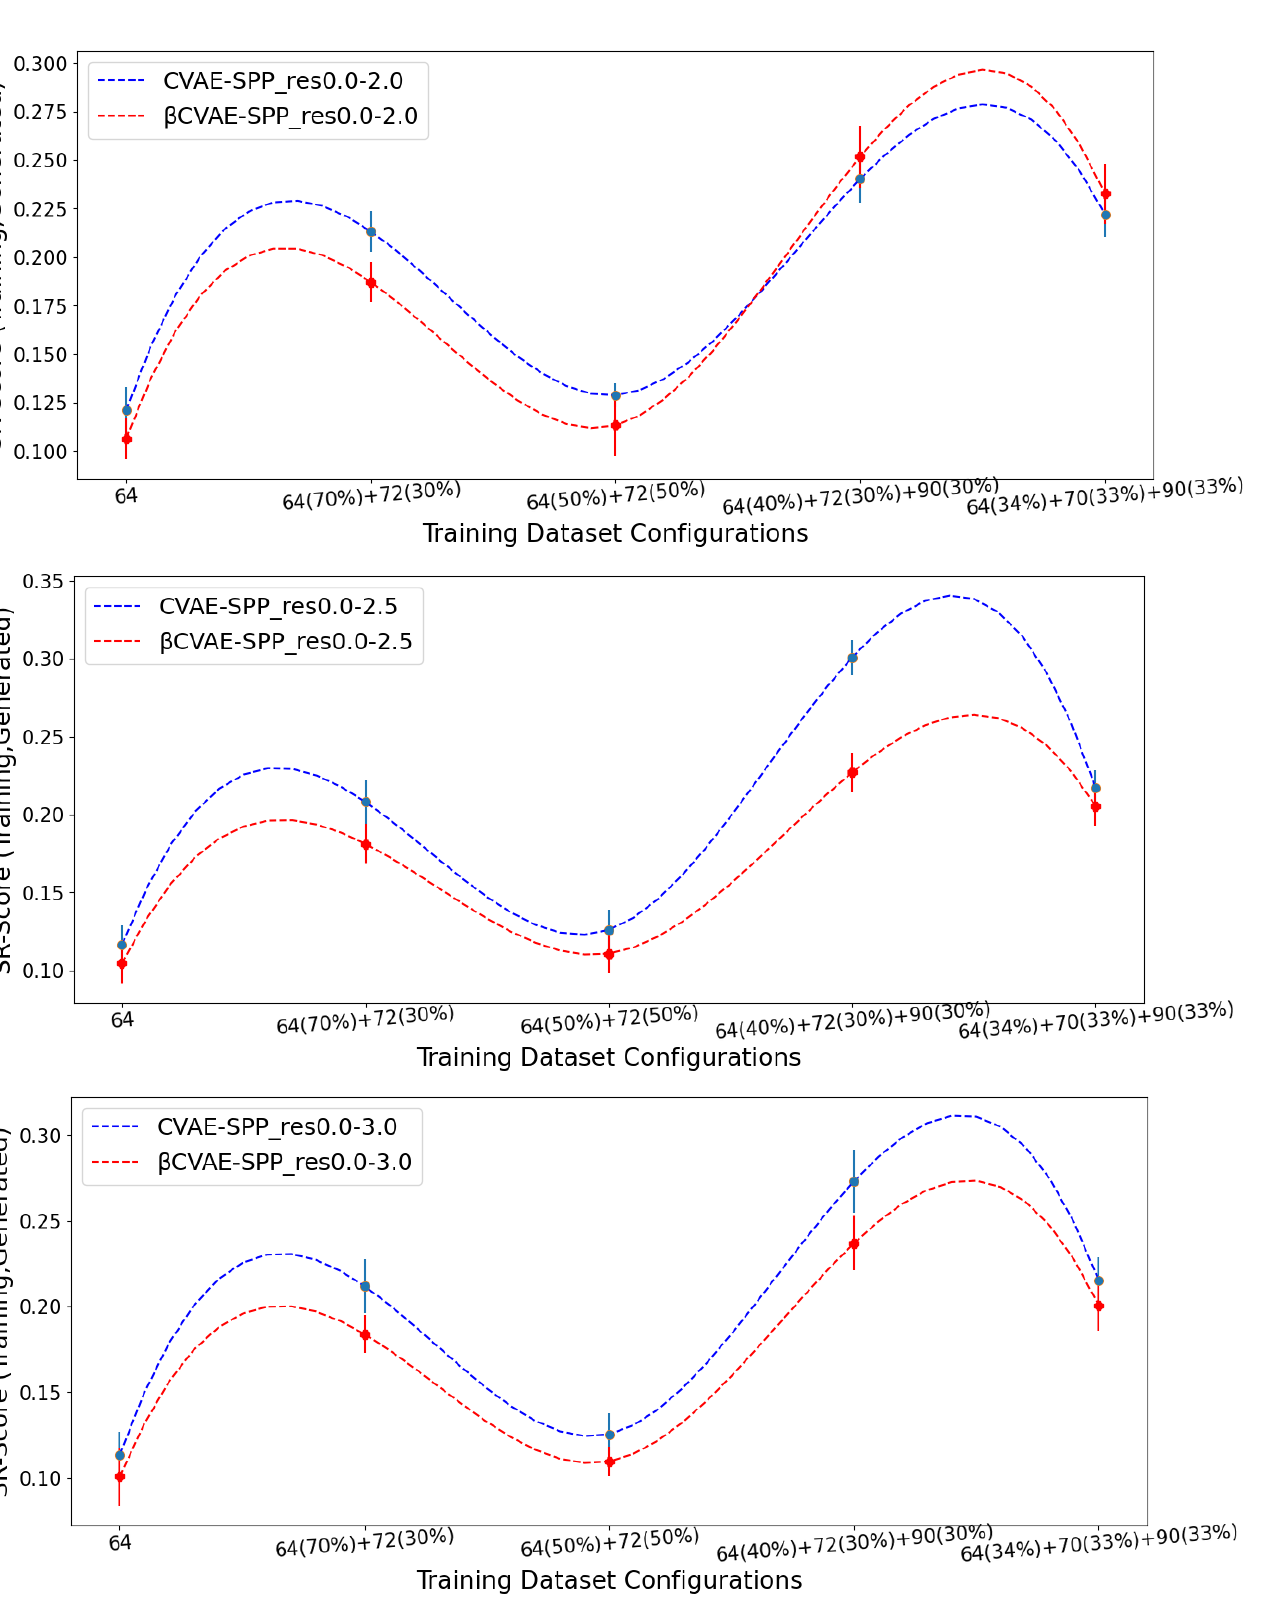
Figure 4. Average of EMD values over SR-Score distributions (over 3 independent runs) computed over generated versus training distance matrices by CVAE-SPP and β CVAE-SPP. Each model is trained on a training dataset configuration ( x axis) of an input dataset. The three panels relate the different input